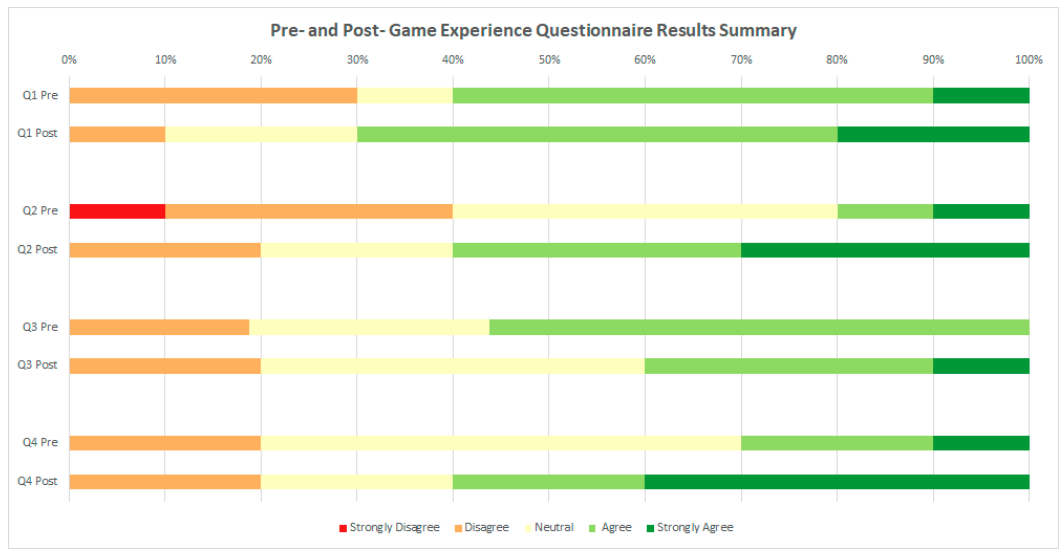
Figure 6. Summary of pre ‐ and post ‐ game experience questionnaire results.